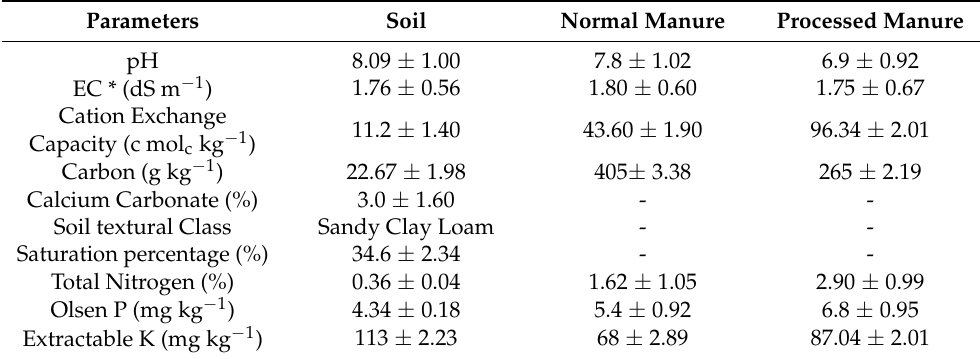
Table 1. Characteristics of soil, fresh and processed animal manure used for